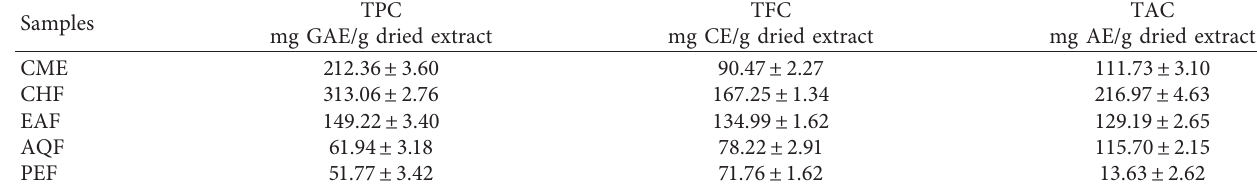
Table 1: Quantitative phytochemical analysis of different extracts of S. japonica .